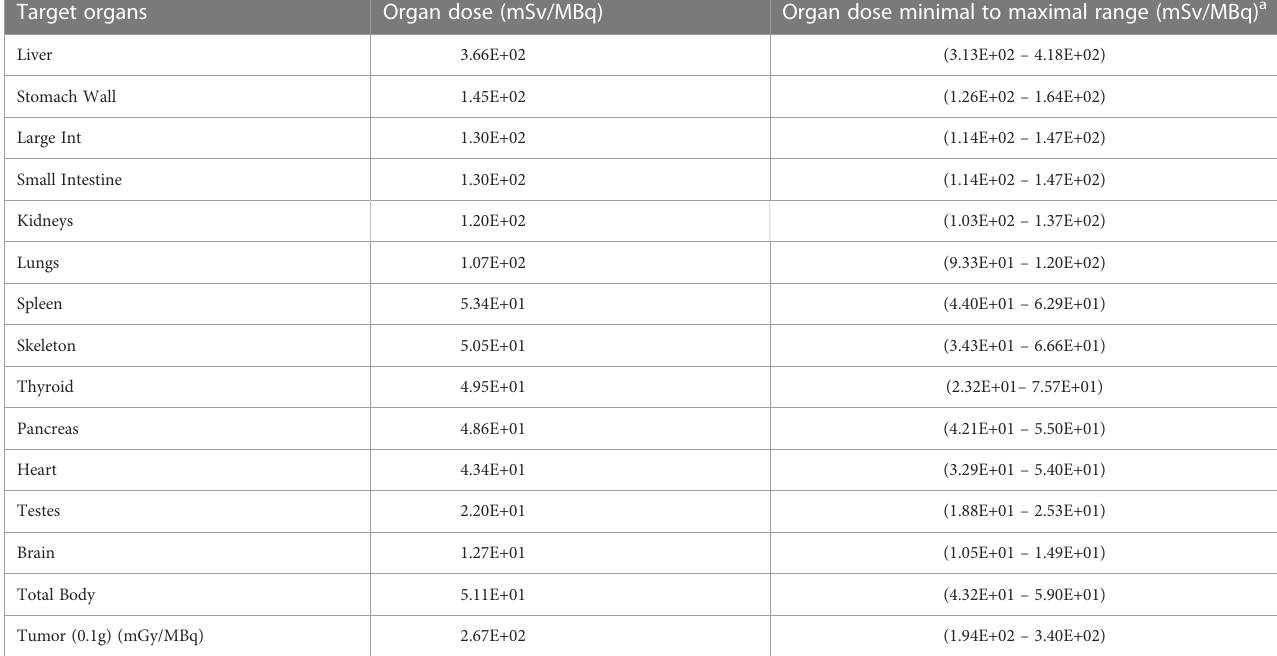
TABLE 1 Mouse 64 Cu-DOTHA 2 -PSMA dosimetry. Target organs Organ dose